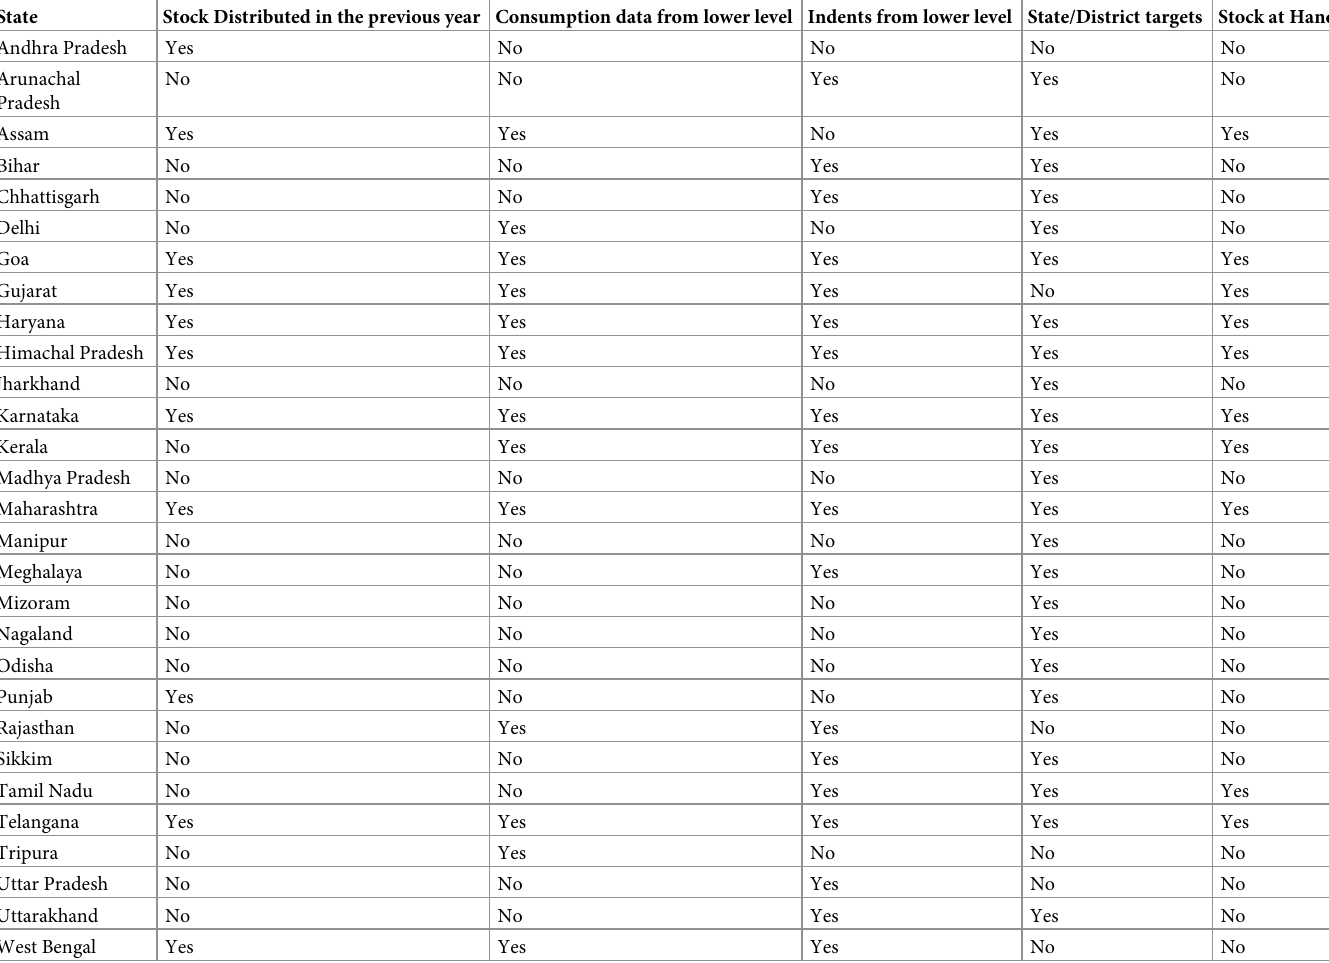
Table 3. Factors considered while forecasting the procurement requirements for IFA supplements across states / UTs, 2018–19.